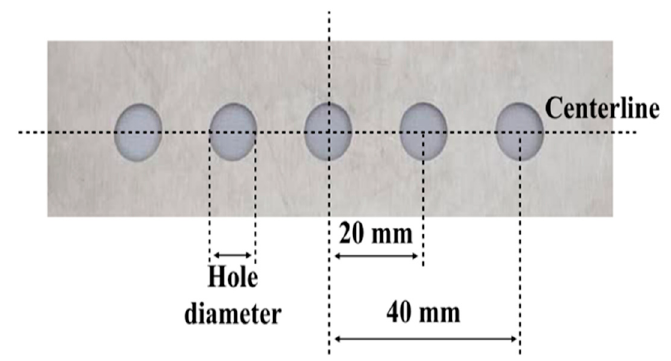
Figure 6. Schematic diagram of the hole distributions on the mask.